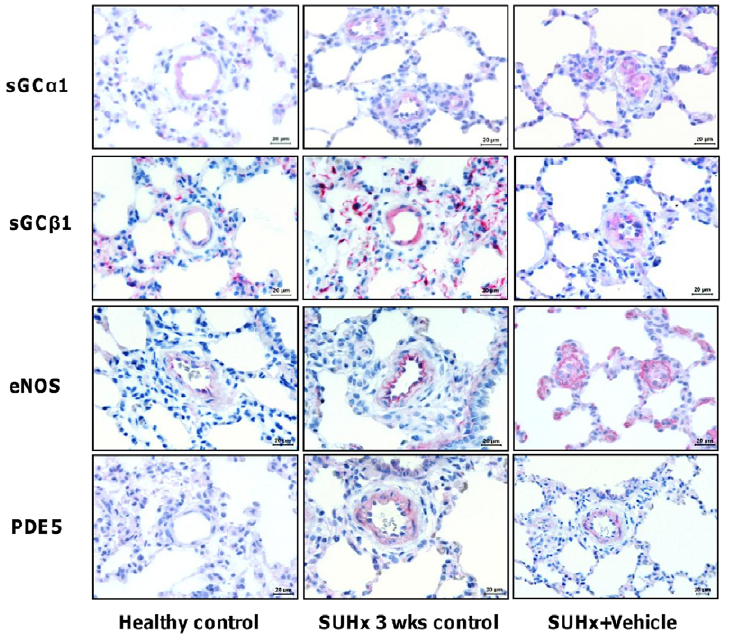
Figure 4. Localization of sGC a 1, sGC b 1, eNOS and PDE-5 in pulmonary vessels of SUHx rats. Localization of sGC a 1, sGC b 1, eNOS and PDE-5 are presented in healthy controls, SUHx 3-week control animals and vehicle-treated animals. Note. eNOS, endothelial nitric oxide synthase; PDE-